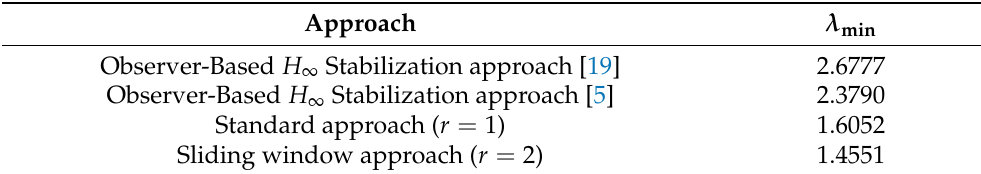
Table 1. Different values of λ min